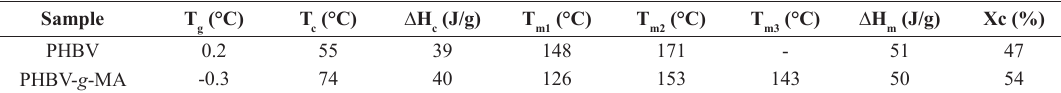
Table 2. Crystallization temperature (T transition temperature (T